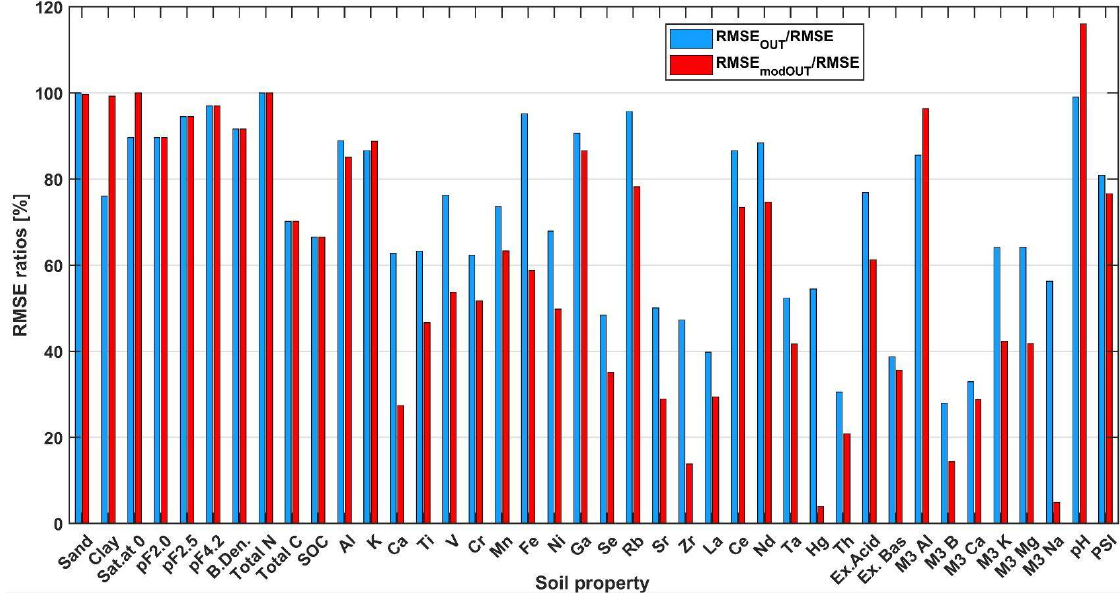
Figure 9. Example RMSE ratios.